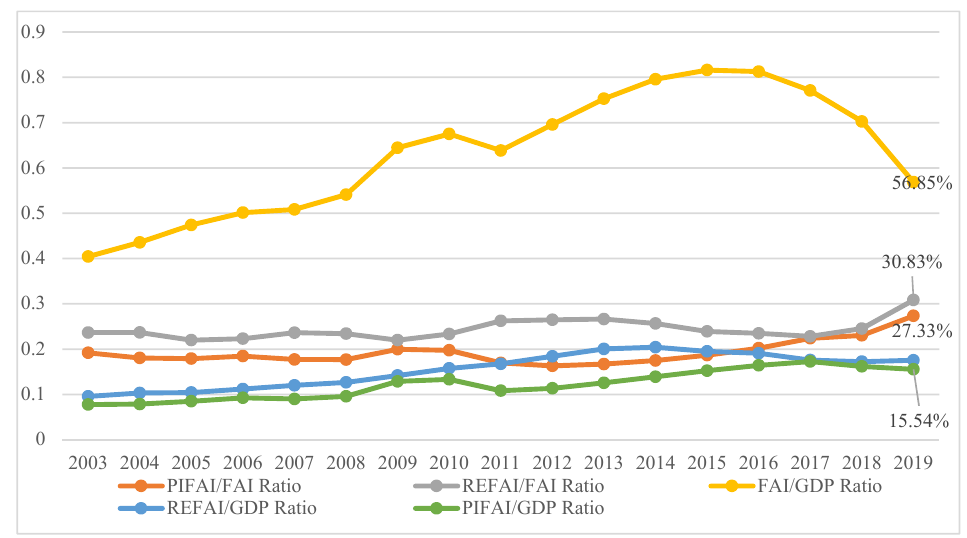
Figure 6. Public infrastructure investment, real estate investment and total fixed assets investment ratio changes from 2005 to 2017. Source: China Statistical Yearbook: 2005 to 2017.